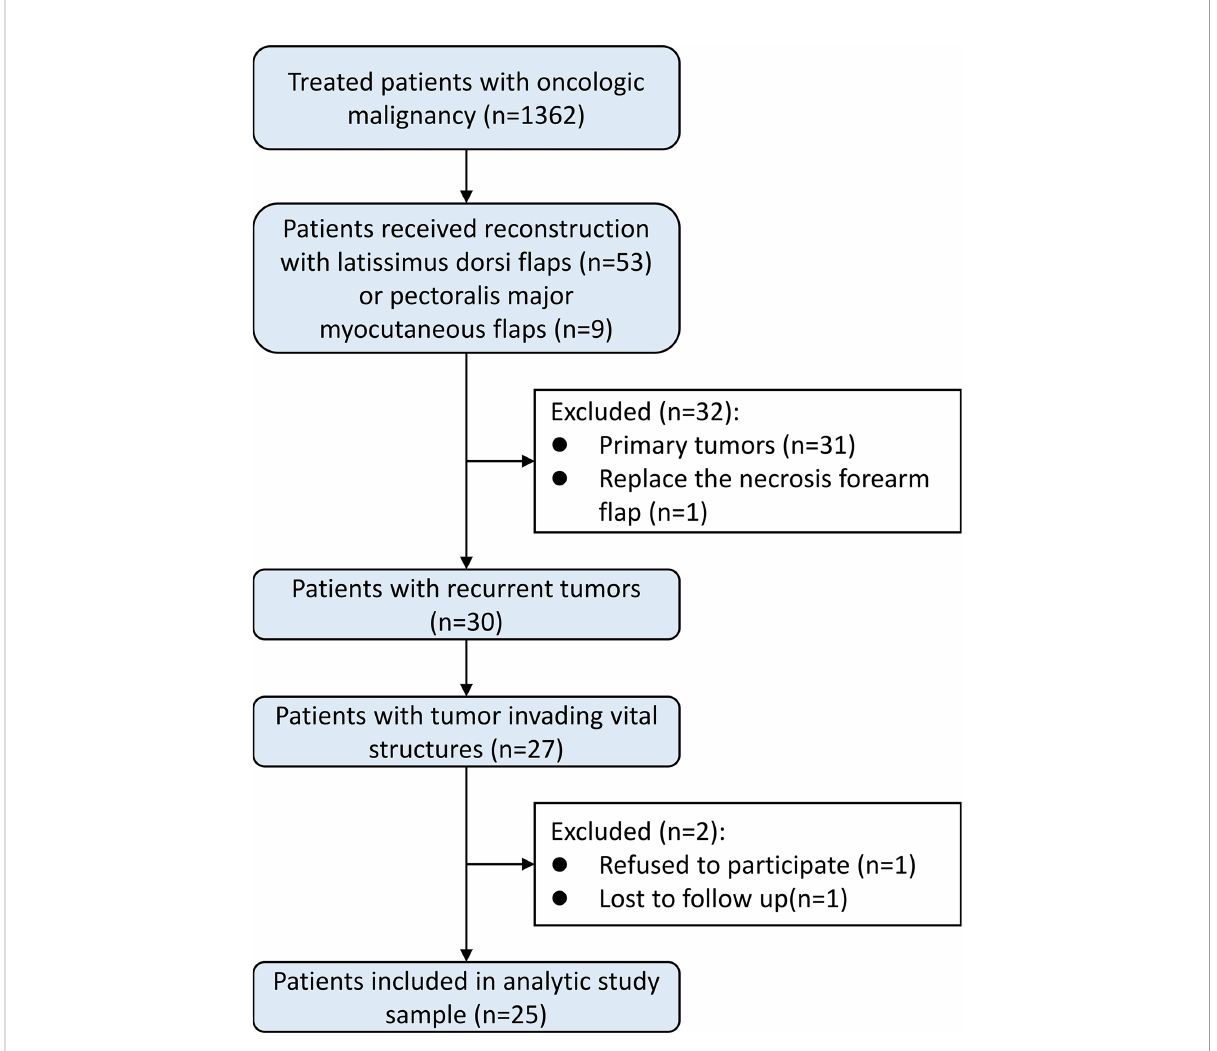
FIGURE 1 Flow chart of identi fi cation of eligible